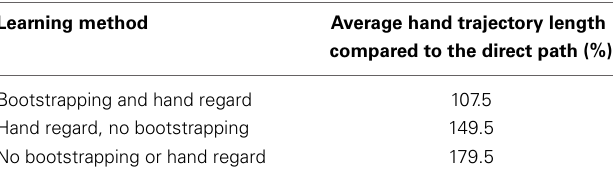
Table 9 | Reach length comparison.